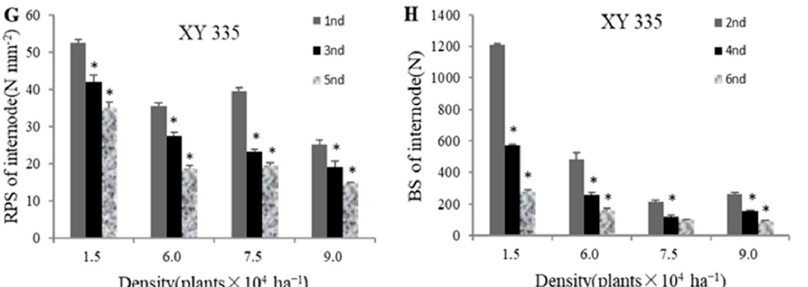
Figure 3. Stalk mechanical strength of DH618 and XY335 at VT + 35d. ( A ) RPS of internode for DH618 under different planting densities in 2014. ( B ) BS of internode for DH618 under different planting densities in 2014. ( C ) RPS of internode for XY335 under different planting densities in 2014. ( D ) BS of internode for XY335 under different planting densities in 2014. ( E ) RPS of internode for DH618 under different planting densities in 2016. ( F ) BS of internode for DH618 under different planting densities in 2016. ( G ) RPS of internode for XY335 under different planting densities in 2016. ( H ) BS of internode for XY335 under different planting densities in 2016. * Significant difference at p < 0.05.